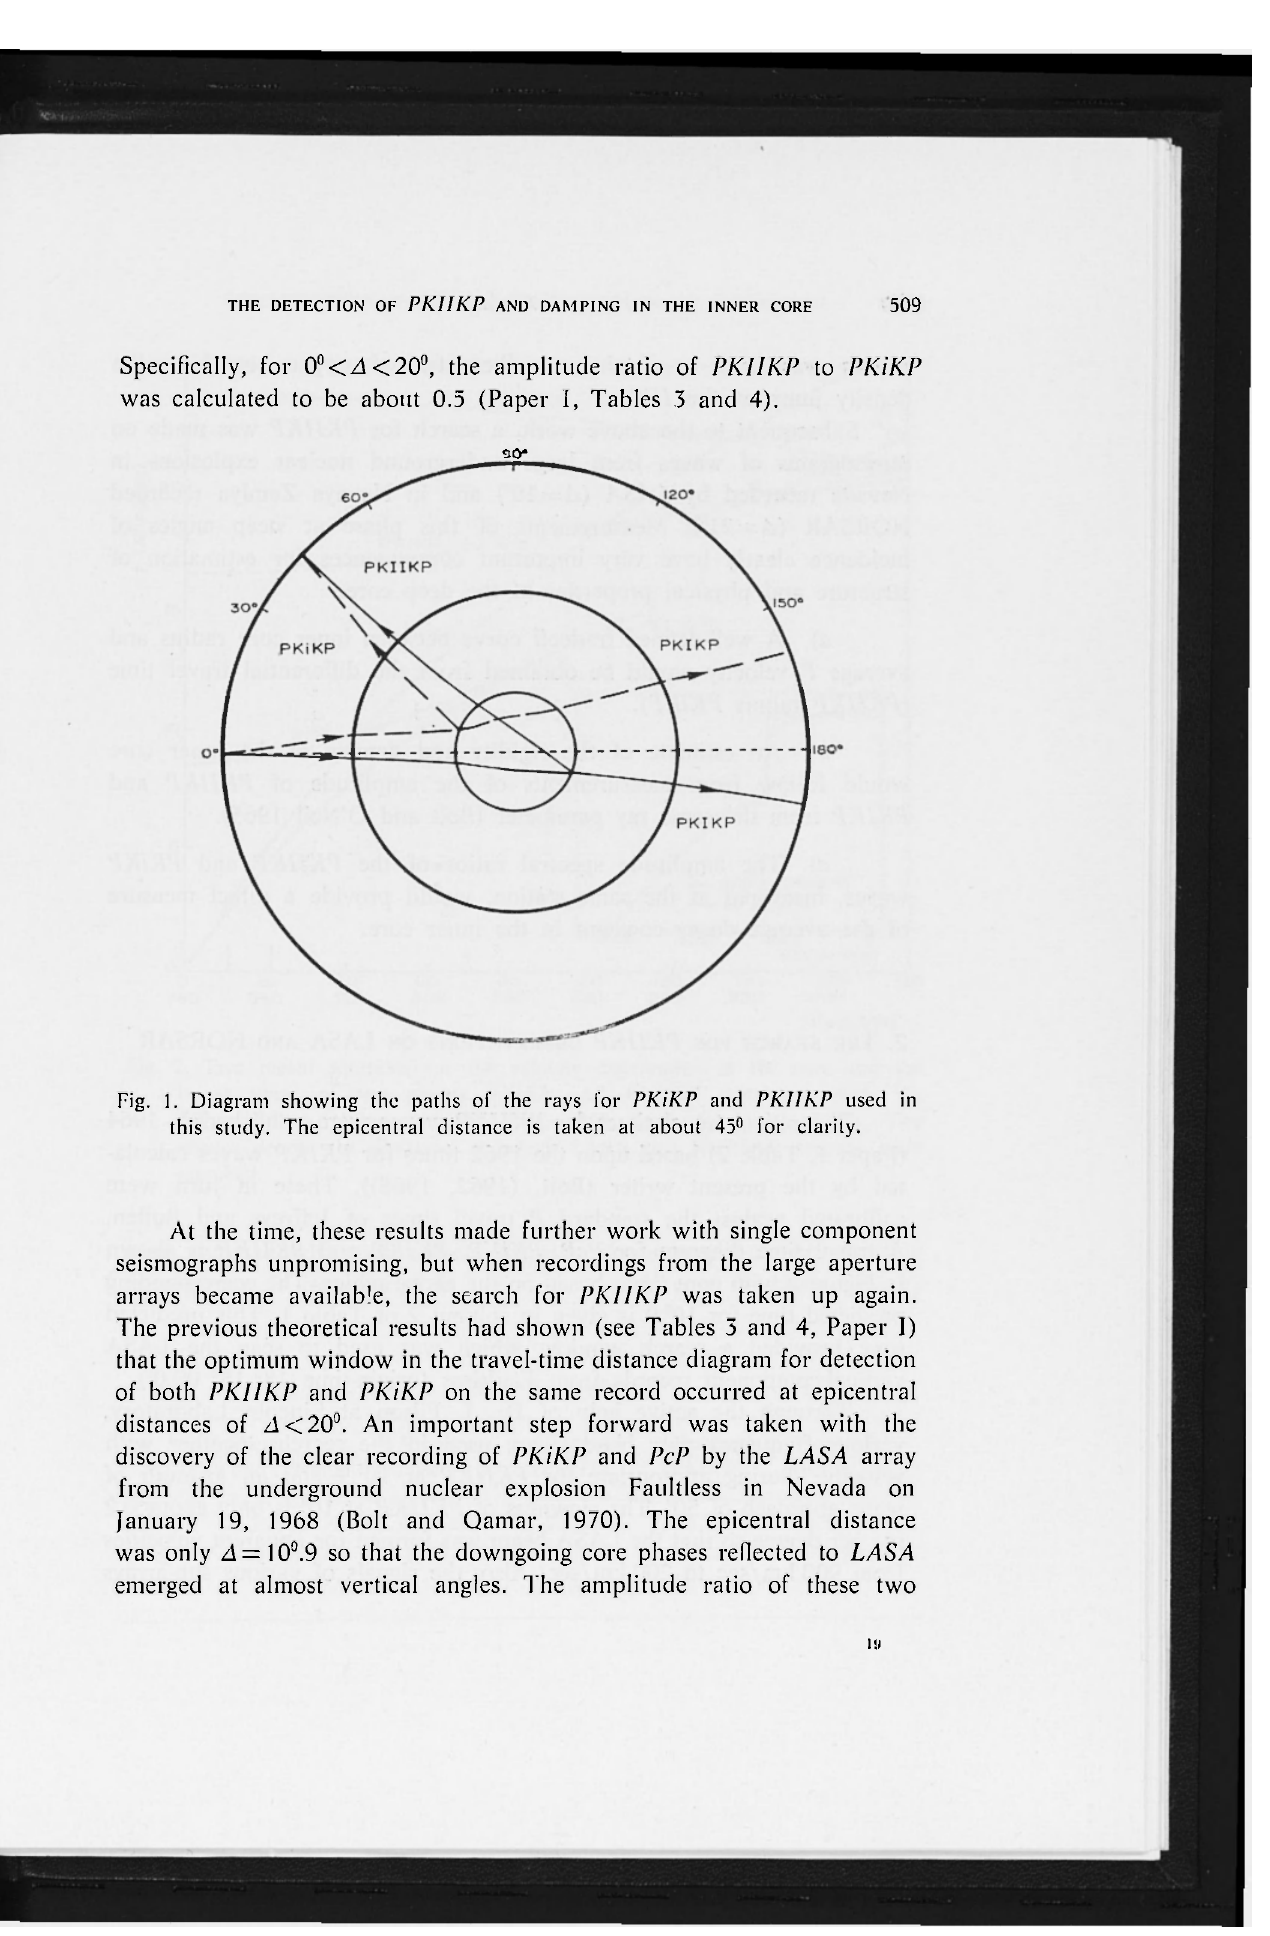
Fig. 1. Diagram showing the paths of the rays for PKiKP and PKIIKP used in this study. The epieentral distance is taken at about 45° for